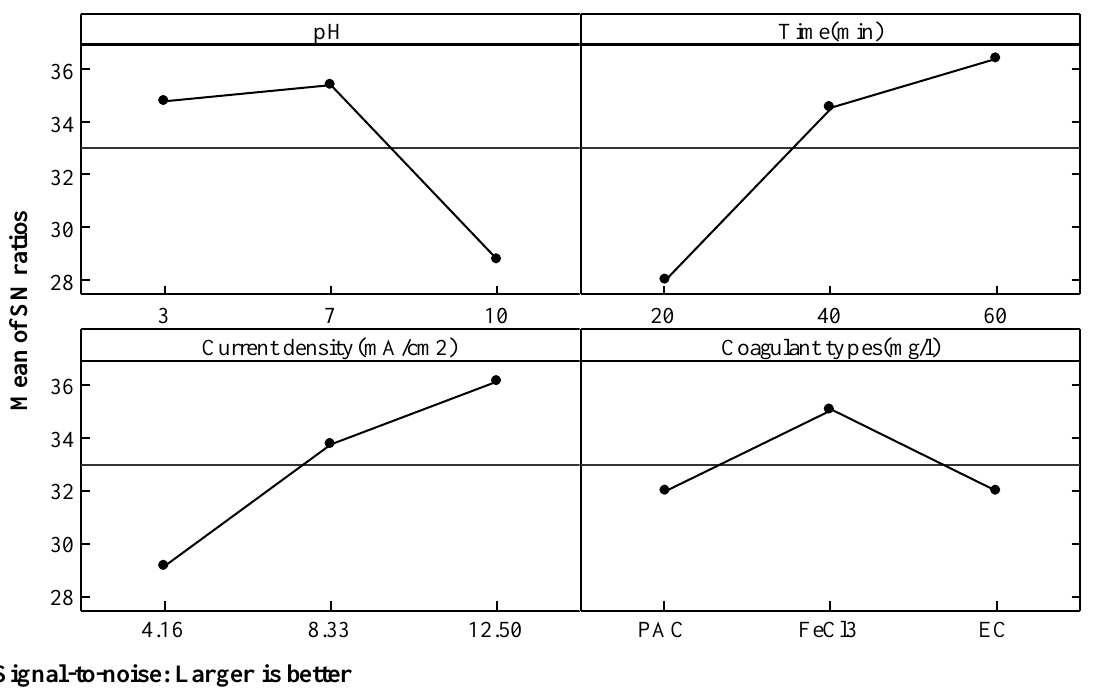
Fig. 1. Main effects plot of the independent parameters for the response of Cr +6 removal efficiency (%) in Taguchi